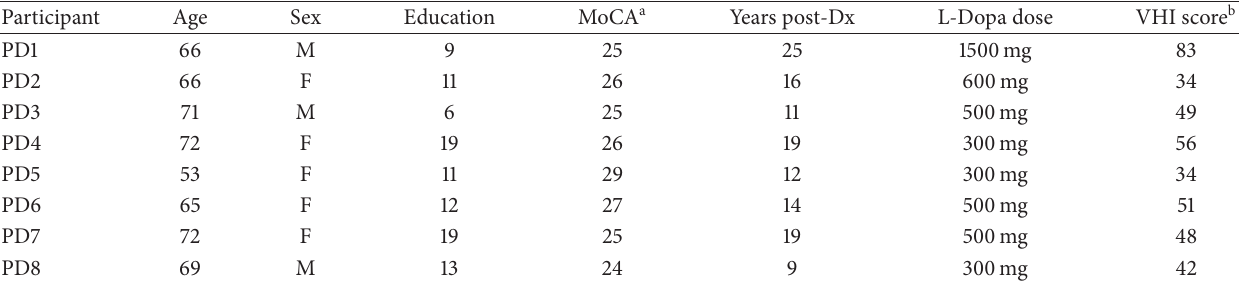
Table 1: Characteristics of participants.